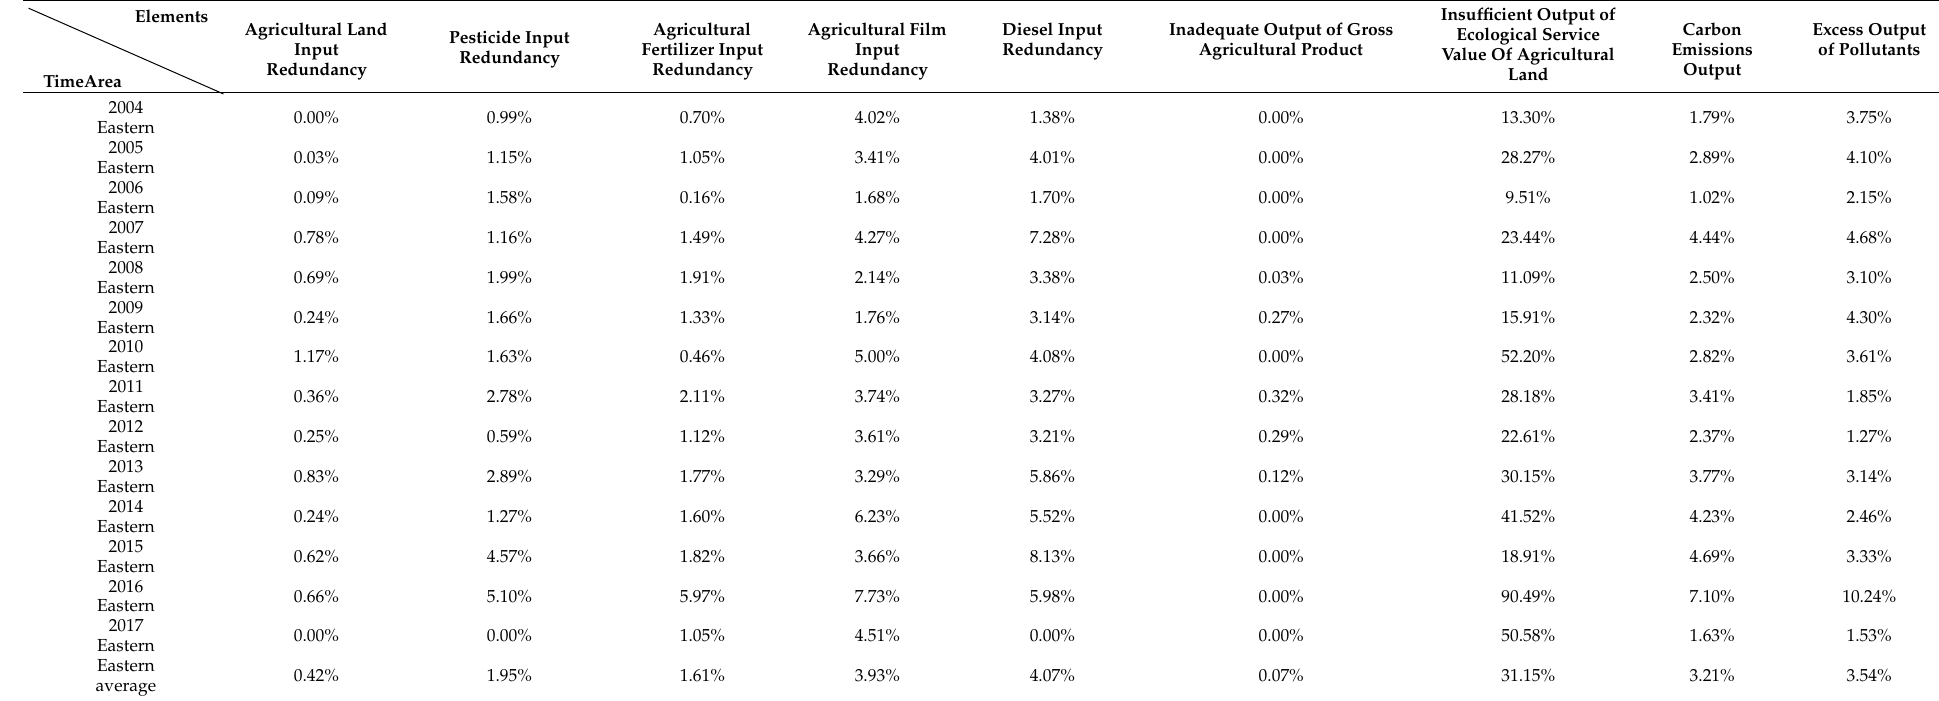
Table 4. Changes in input redundancy, desired output deficiency, and non-desired output excess in ecological land use processes in eastern